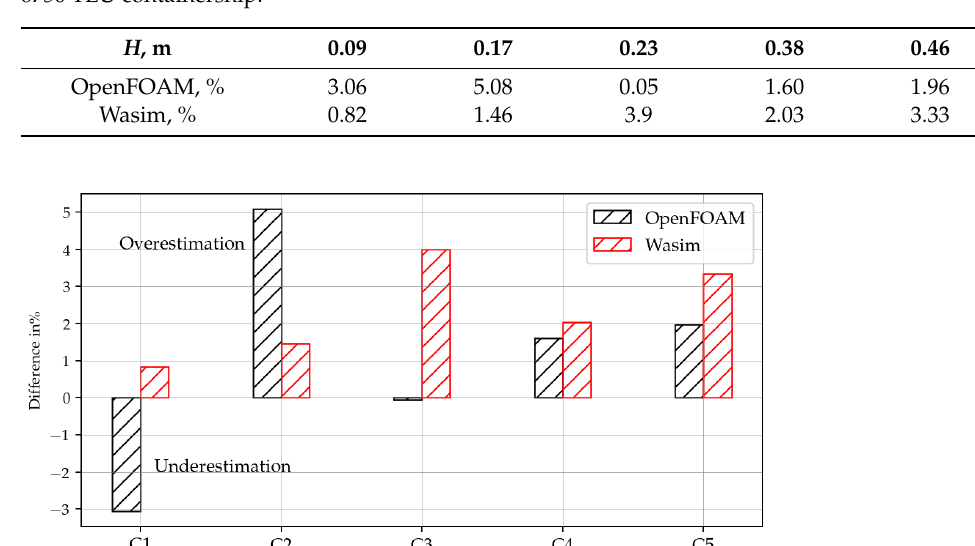
Table 7. Difference of nondimensional numerical and experimental pitch amplitudes for the 6750 TEU containership.